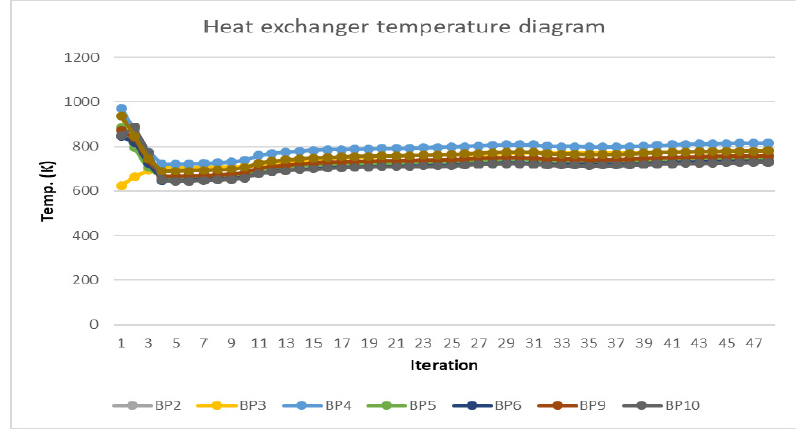
Figure 17. Heat exchanger temperature diagram.